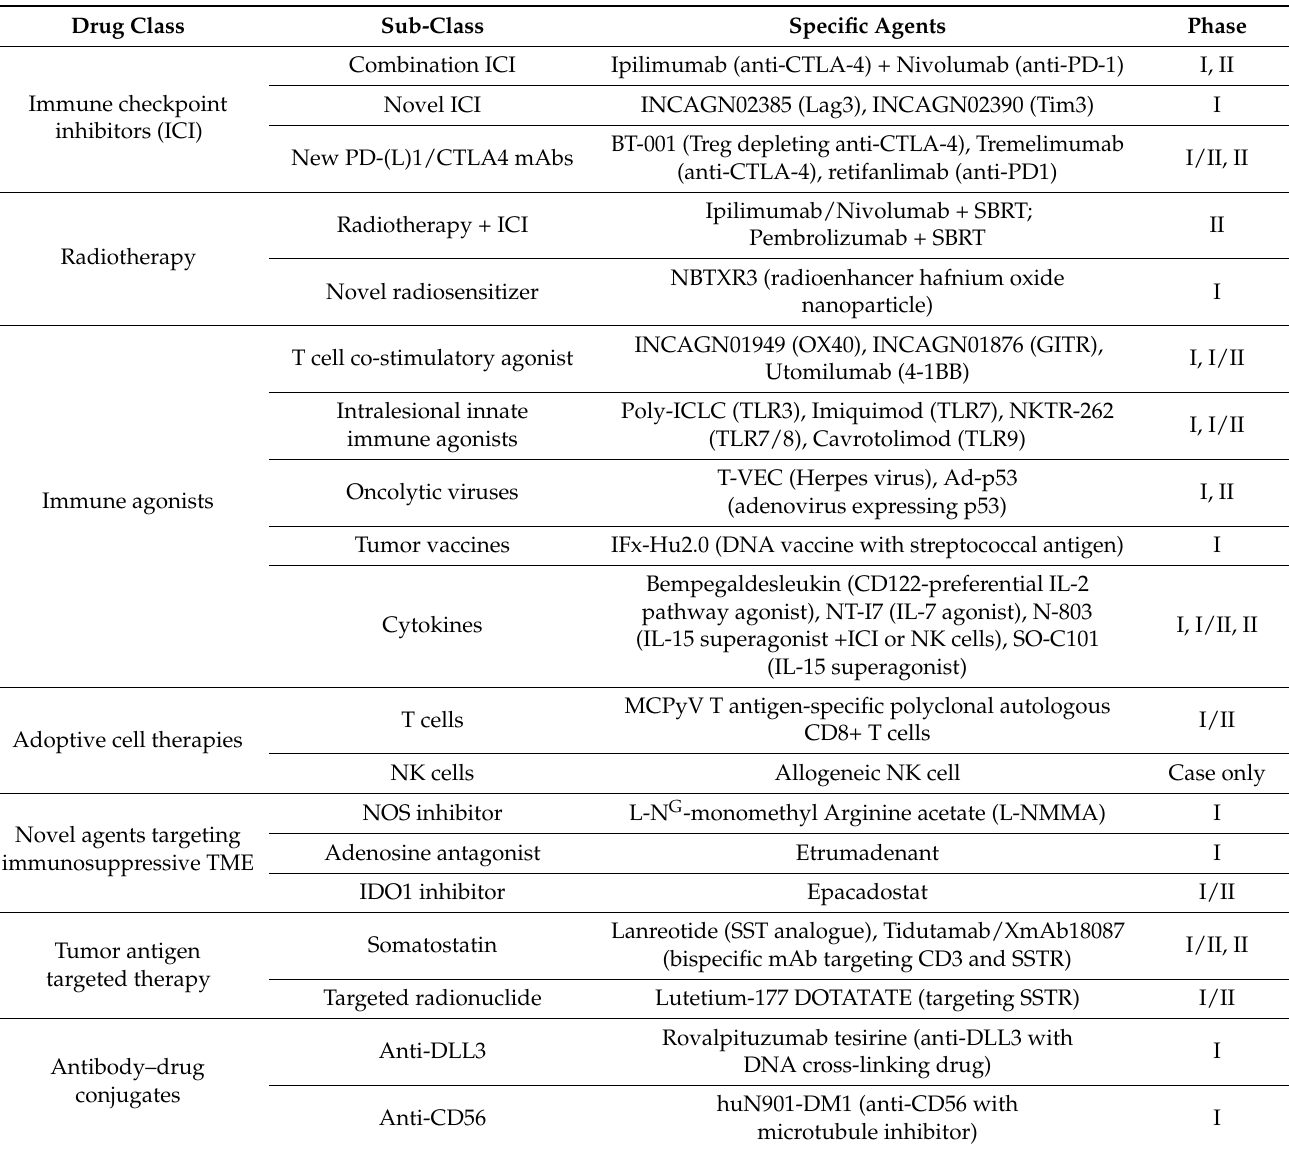
Table 2. Novel therapeutic agents potentially available to MCC patients on clinical trials or with recently completed trials. Drug